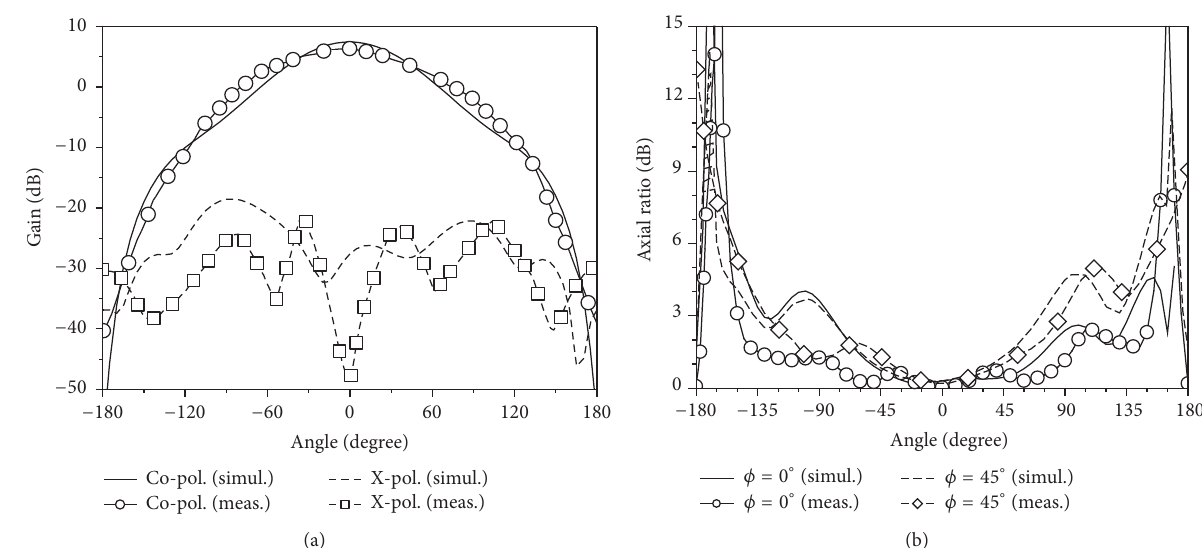
Figure 8: (a) Co-/cross-polarized gain patterns and (b) axial ratio patterns of the fabricated feed at 5.5